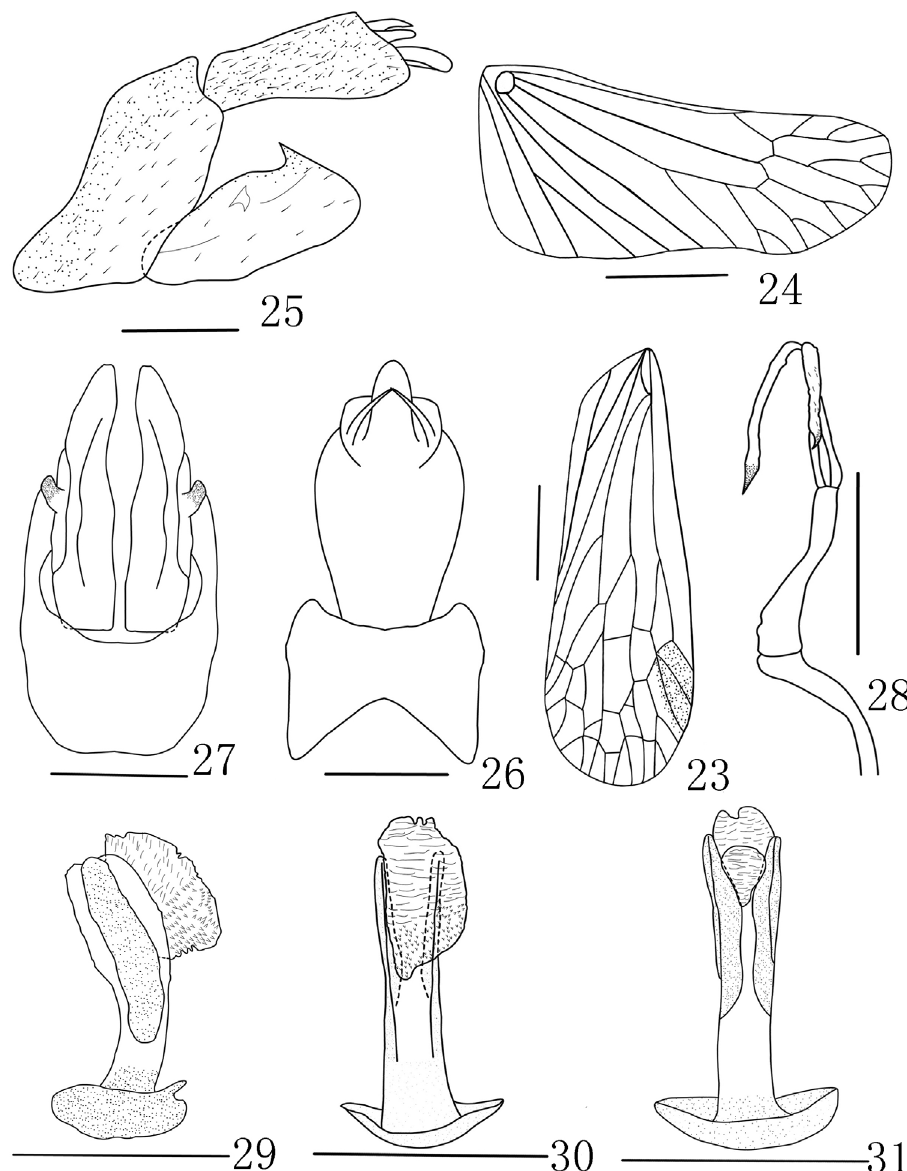
Figures 23–31. Saigona maculata Zheng & Chen sp. nov. 23 forewing 24 hindwing 25 genitalia, lateral view 26 pygofer and anal tube, dorsal view 27 pygofer and gonostyles, ventral view 28 aedeagus process 29 aedeagus, lateral view 30 aedeagus, ventral view 31 aedeagus, dorsal view. Scale bars: 2 mm ( 22–30 ), 0.5 mm ( 28–34